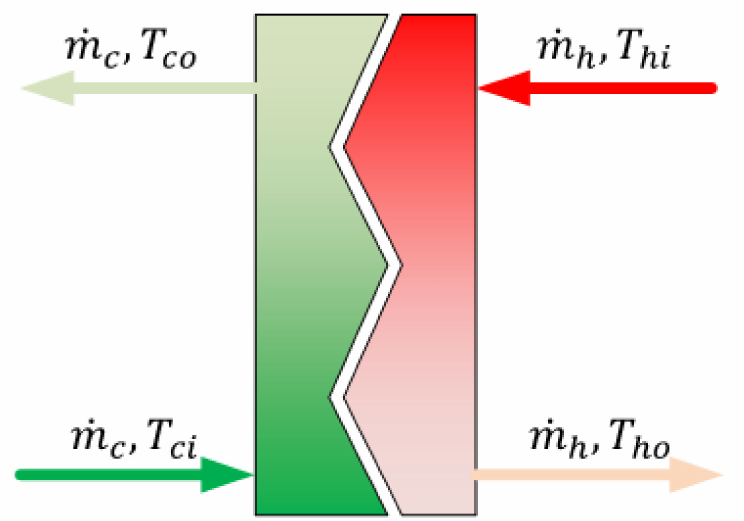
Figure 4. Simplified plate-type heat